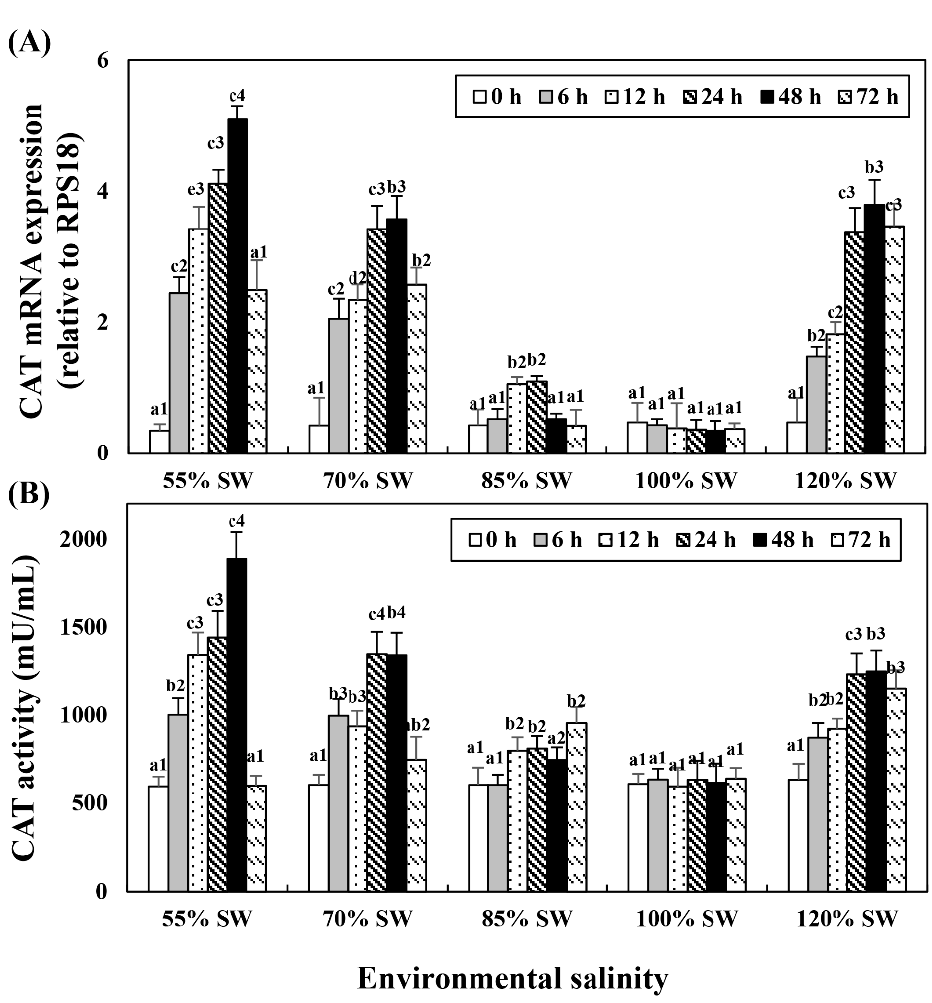
Figure 3. Changes in the expression levels of ( A ) CAT mRNA in the digestive diverticula and ( B ) CAT activity in the hemolymph of A. irradians during a 72 h period after sudden salinity change. Different characters indicate values corresponding to different exposure times of the scallops within the same salinity concentration ( p < 0.05). Numbers indicate significant differences among salinity concentrations for the same exposure time ( p < 0.05). All values are presented as the mean ± SD ( n = 5). Abbreviations: CAT, catalase and SD, standard deviation.